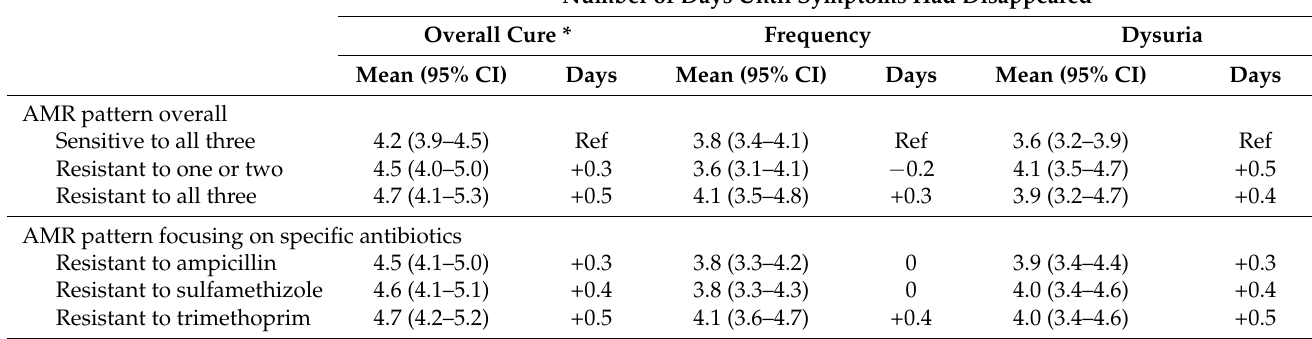
Patients felt all UTI symptoms had disappeared.